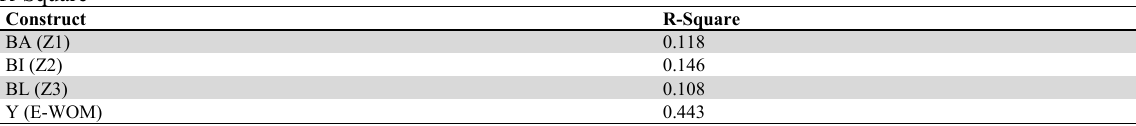
Cronbach’s Alpha